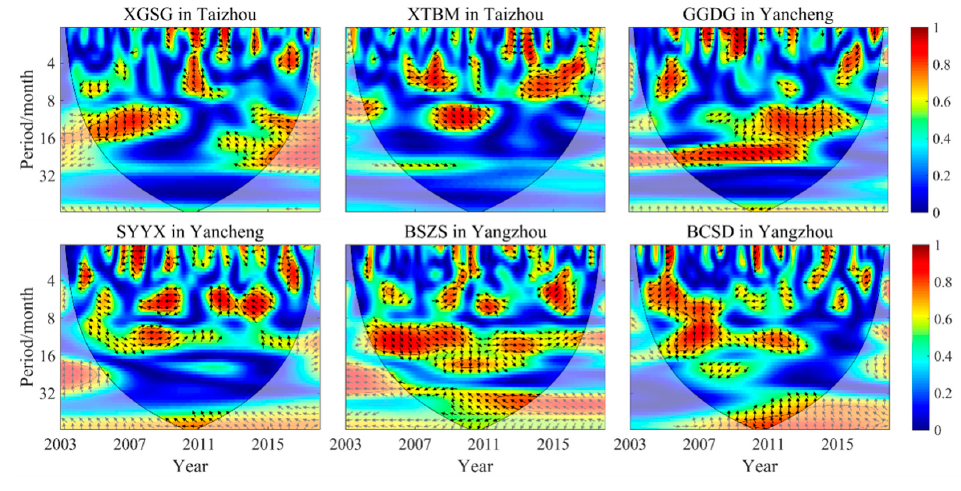
Figure 7. Results of XWT ( a ) and WTC ( b ) of the CWQI and the amount of diversion water at six representative stations. The color scale on the right side of the figure represents the density of the cross wavelet power spectrum, and the arrow direction reflects the phase relationship between the CWQI and water level: ‘ → ’ represents the same phase, ‘ ← ‘ represents the opposite phase, ‘ ↓ ‘ represents that the CWQI lags behind the water level by one-quarter of a cycle, and ‘ ↑ ‘ represents that the CWQI advances the water level by one-quarter of a cycle.